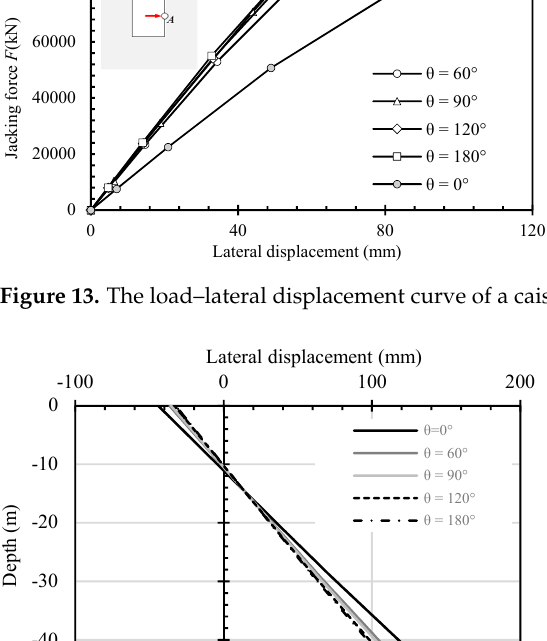
Figure 13. The load–lateral displacement curve of a caisson with different reinforcement angles.